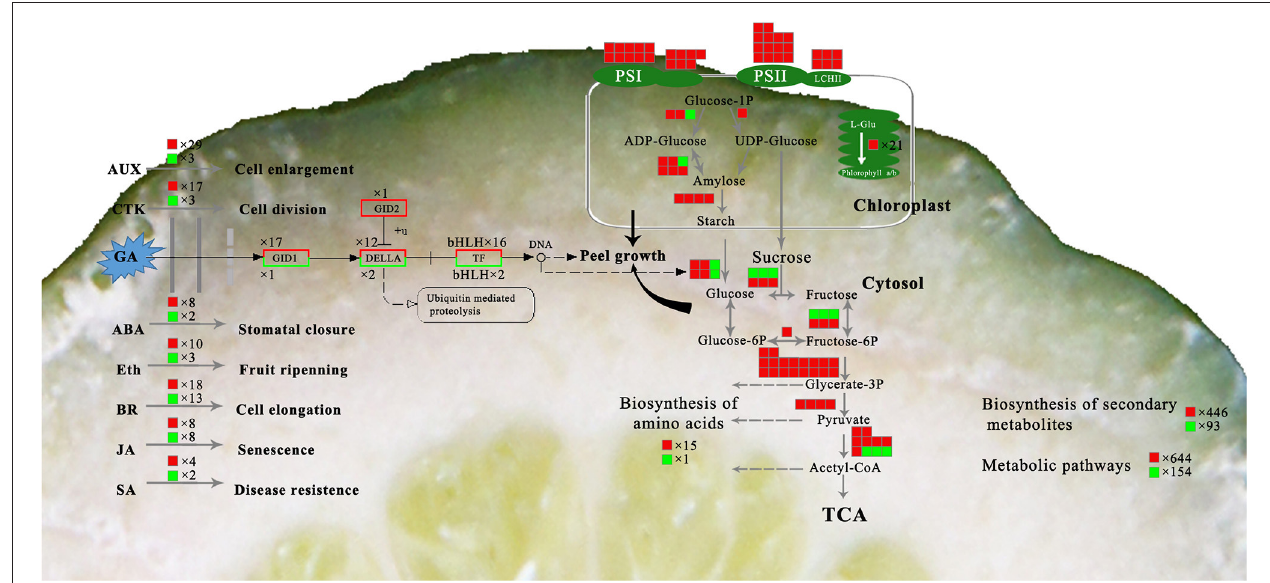
FIGURE 10 | Overview of the major metabolic pathways involved in peel RD. The box background in red indicates up-regulated genes while green indicates down-regulated